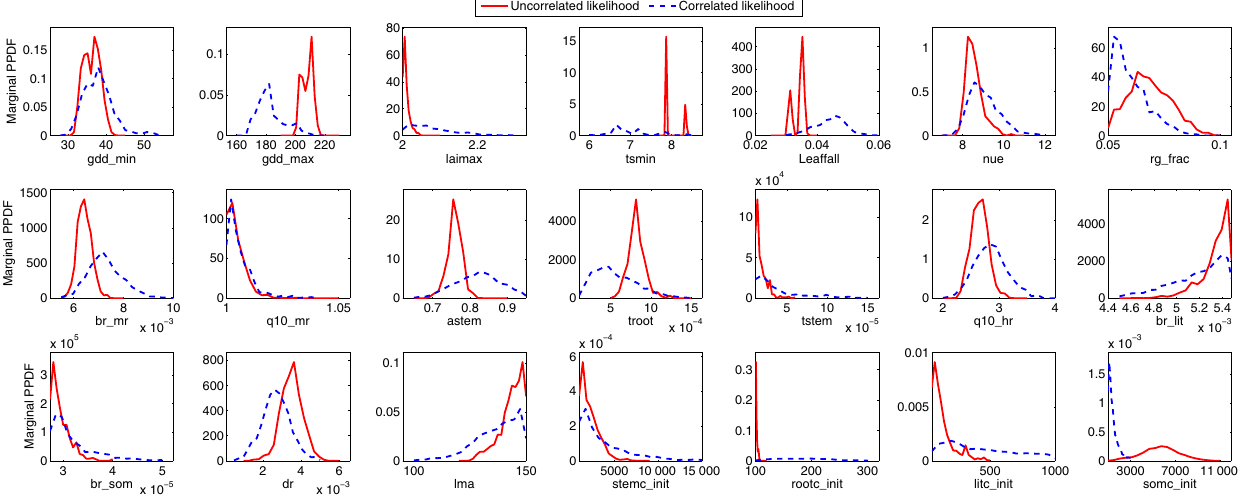
Figure 13. Estimated marginal posterior probability density functions (PPDFs) of the 21 TEM parameters using the uncorrelated and corre- lated Gaussian likelihoods.